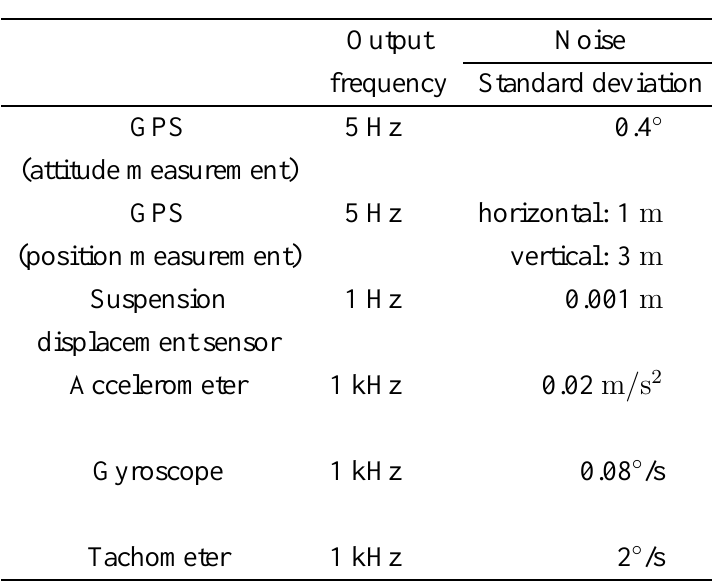
Table 1. Sensor output rates and noise